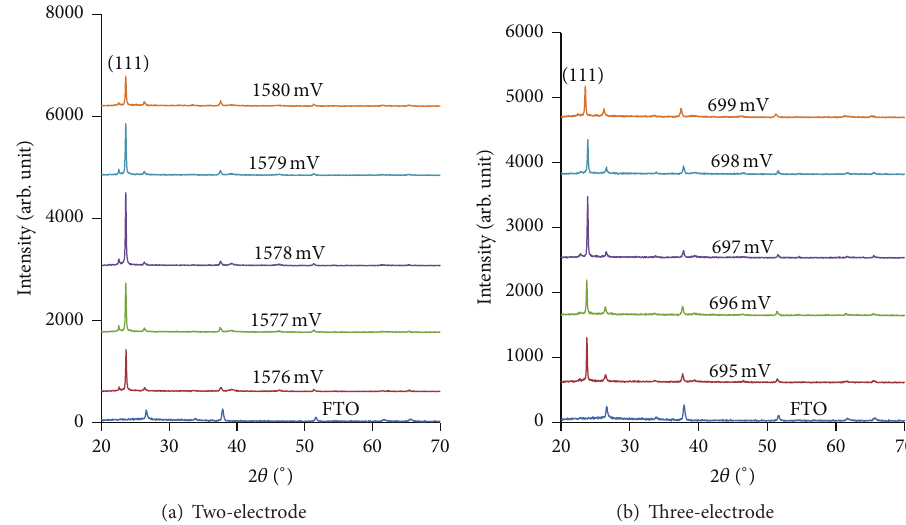
Figure 2: XRD patterns of as-deposited CdTe layers grown at five different cathodic voltages for 1 hour using (a) two-electrode system and (b) three-electrode